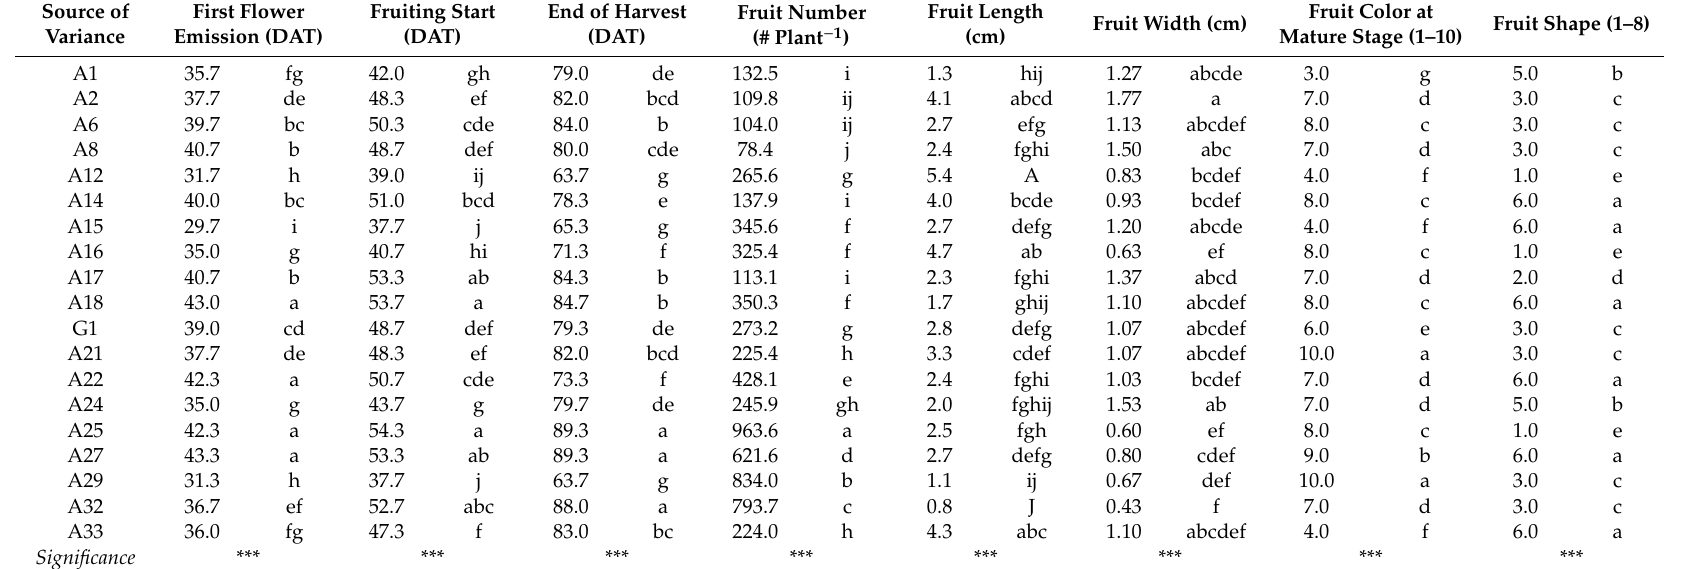
Table 2. E ff ect of 19 chili pepper accessions on first flower emission, fruiting start, end of harvest fruit number, fruit length, fruit width, fruit color at mature stage and fruit shape, in